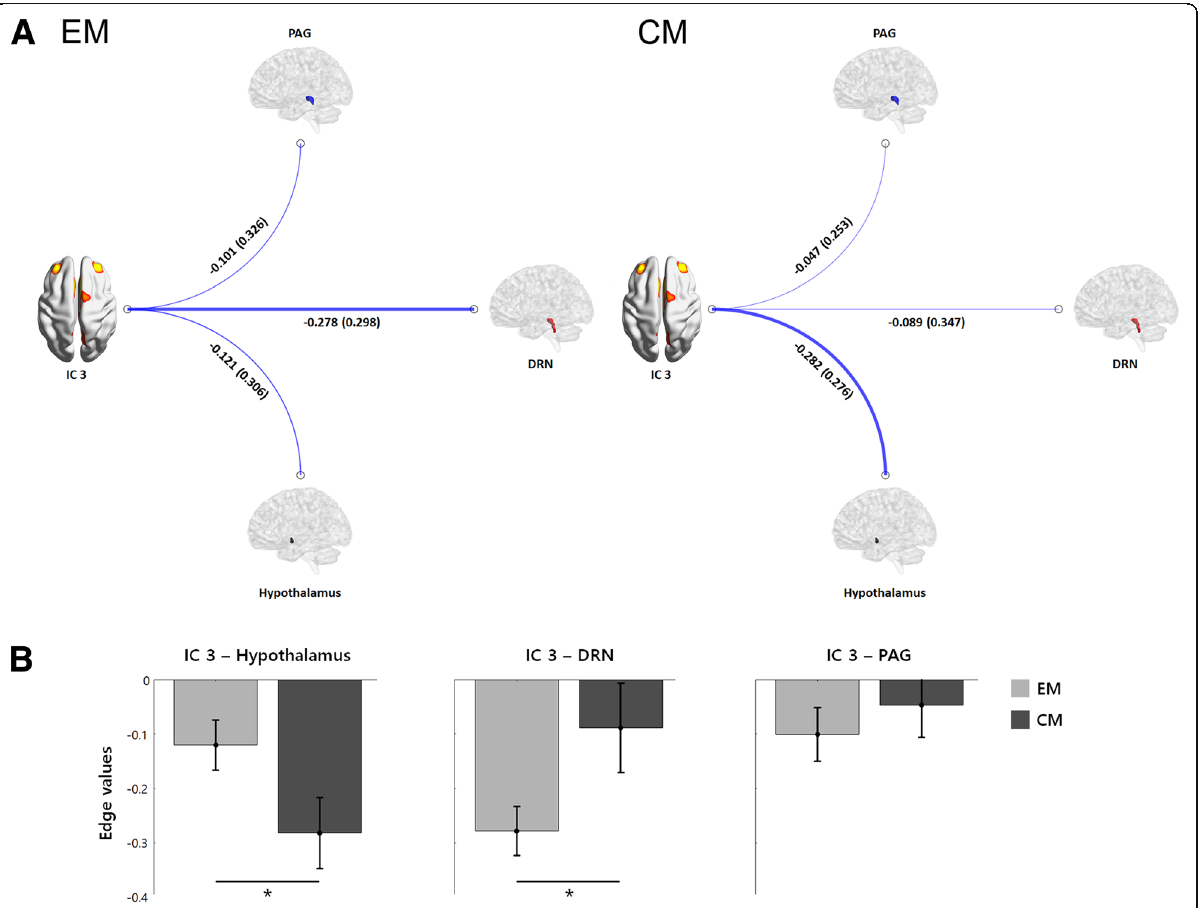
Fig. 5 Functional connectivity of IC 3 (pain matrix) with the hypothalamus, DRN, and PAG. a Functional connectivity of IC 3 with the hypothalamus, dorsal raphe nuclei (DRN), and periaqueductal gray (PAG) are illustrated. The mean (SD) of edge values are shown and the width of the lines indicate the magnitude of edge weights. b Between-group analysis of connectivity between IC 3 and each region are summarized. Patients with CM showed a stronger connectivity between IC 3 and the hypothalamus (FDR-corrected p = 0.0399), whereas the connectivity between the DRN and IC 3 was stronger in patients with EM (FDR-corrected p = 0.0390). No between-group difference in the connectivity between IC 3 and the PAG were noted (FDR-corrected p =